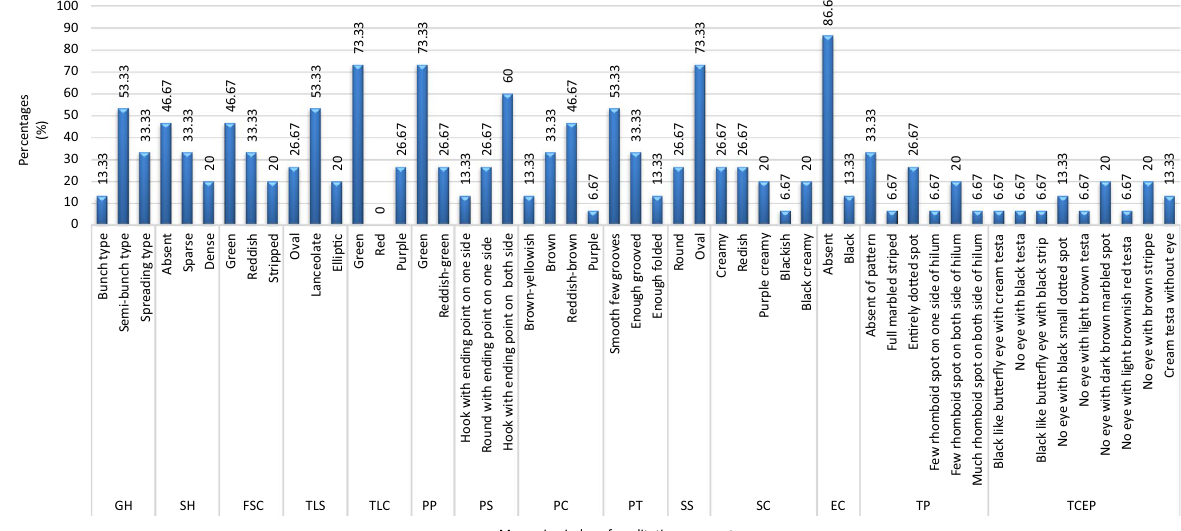
Figure 2. Graphical display of qualitative traits’ frequency distribution of Bambara groundnut accessions. GH growth habits, SH stem hairiness, FSC color of first stem, TLS shape of terminal leaflet, TLC terminal leaf color, PP petiole pigmentation, PS pod shape, PC pod color, PT pod texture, SS seed shape; SC seed color; EC eye color, TP Testa pattern, TCEP Testa color with eye pattern round